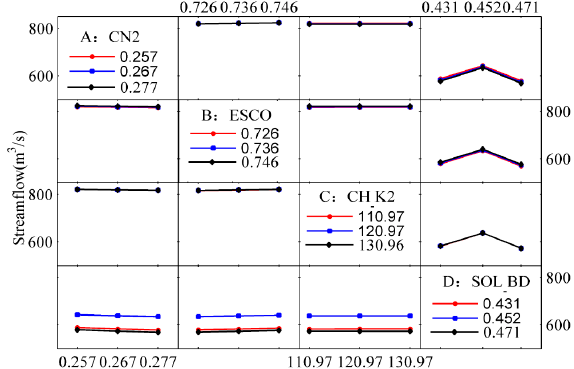
Figure 13. Interaction effects of parameters in the post-flood period.